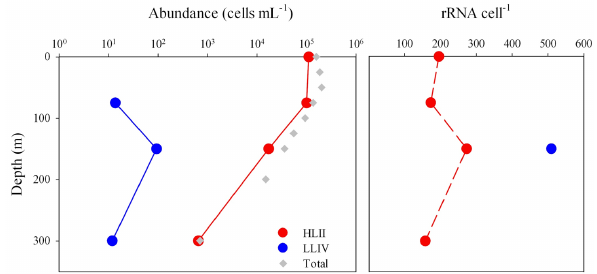
Fig. 3. Vertical profiles of (A) the abundance and (B) cell-specific rRNA content of two dominant Prochlorococcus ecotypes in the Lu- zon Strait area (St. DC01) determined by qPCR. Red, Prochlorococ- cus ecotype HLII; Blue, Prochlorococcus ecotype LLIV. The grey dots show the total Prochlorococcus abundance as determined by FCM at the same